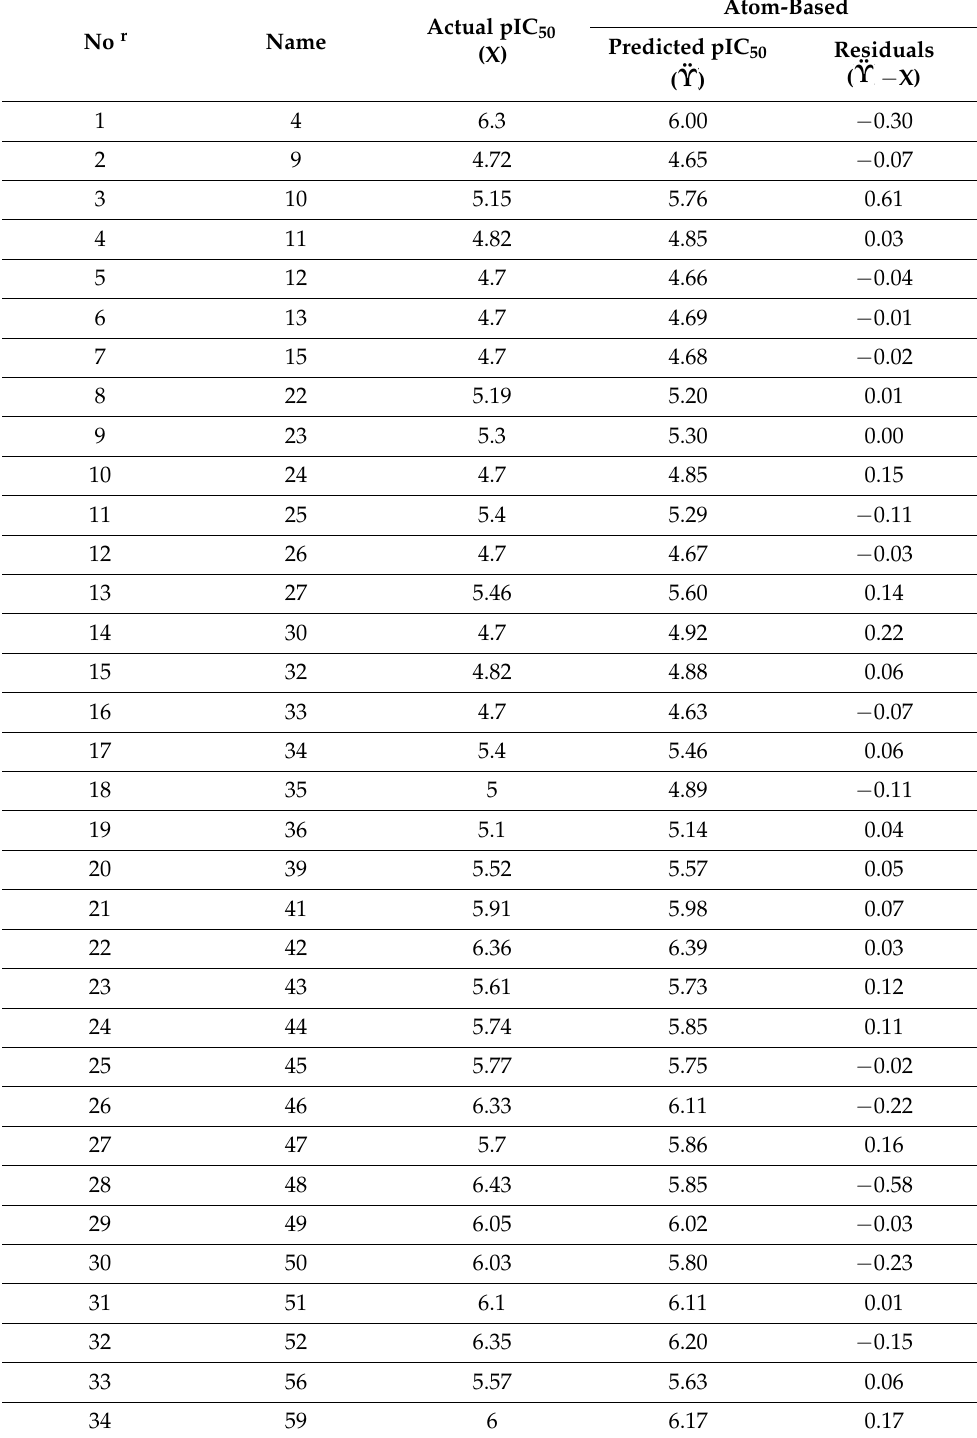
Table 5. Predicted pIC 50 and residual values of generated models.